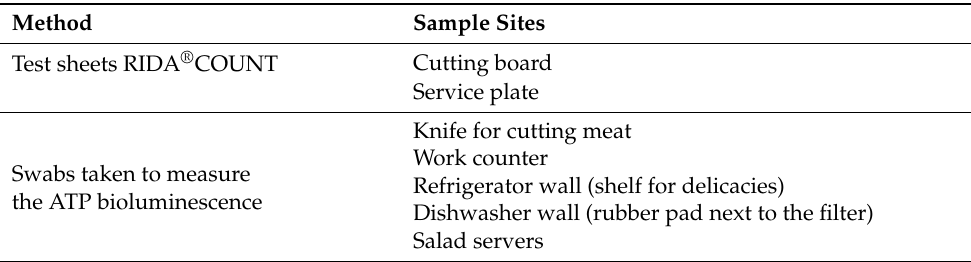
Table 1. A table of the sample sites of test sheets for establishing the total number of aerobic mesophilic microorganisms and the number of coliform bacteria, including E. coli , and the sample sites of swabs taken to measure the ATP bioluminescence.